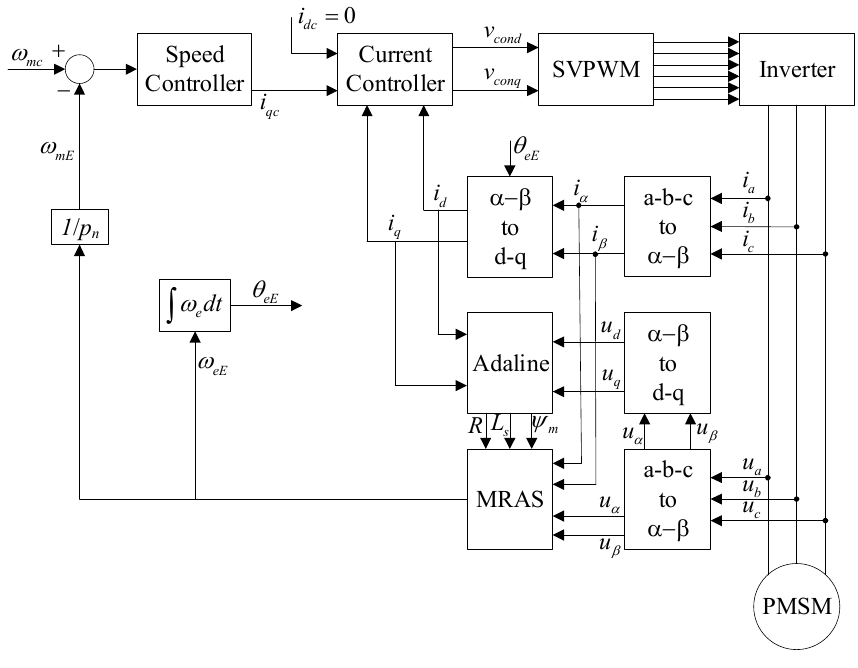
Figure 3. Adaline neural network structure diagram. Figure 3. PMSM control system.